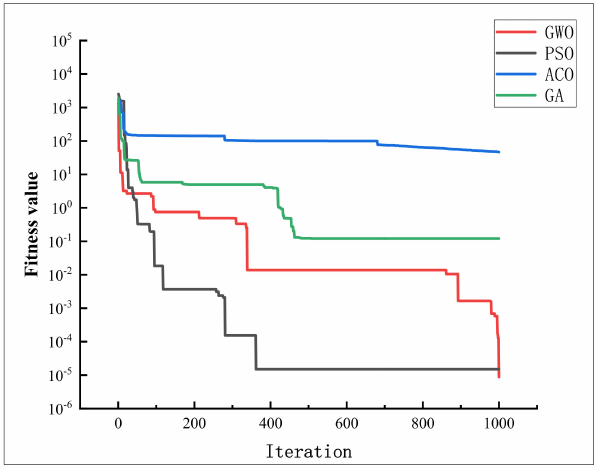
Figure 3. The convergence process of different